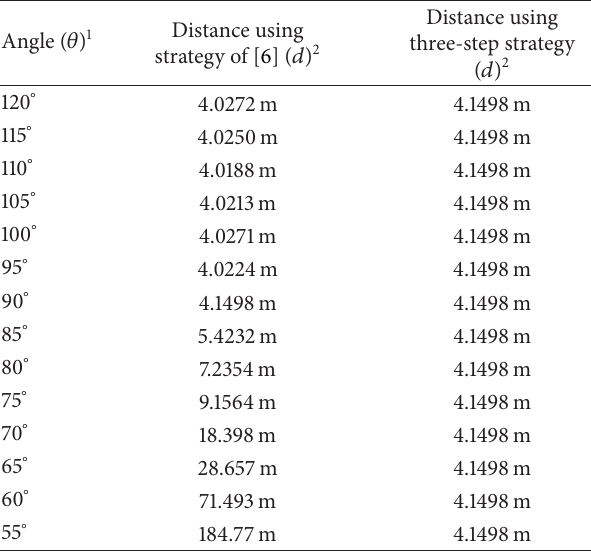
Table 2: Comparison of distance using different strategies.